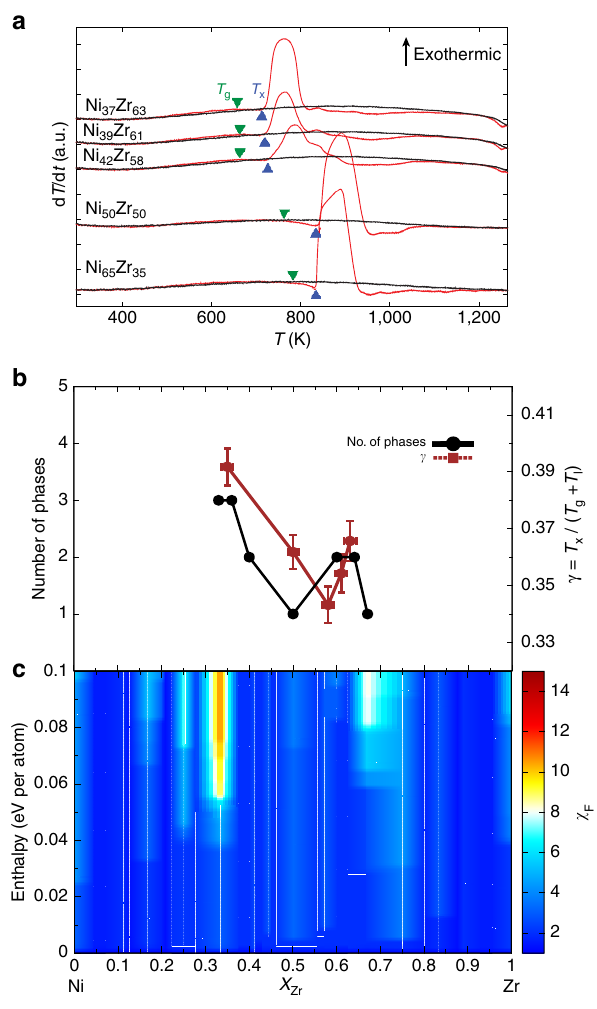
Figure 4 | Experimental and theoretical analysis of NiZr. ( a ) Nanocalorimetry measurements for NiZr during heating at different compositions. The first heating cycle measurements for each composition are shown in red, and subsequent measurements are shown in black. ( b ) Number of phases (solid black line) as measured using X-ray diffraction, and g descriptor calculated for NiZr alloys (dashed brown line). ( c ) Contour plot of the entropic factor as a function of formation enthalpy (zero corresponds to the ground state of the composition). Note the sharp peaks both in the number of states observed in experiment and in the entropic factor at the Ni 35 Zr 65 and Ni 65 Zr 35